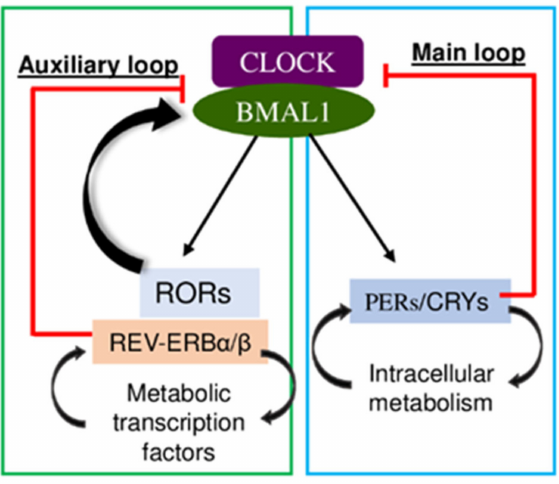
Figure 3. Clock and Bmal1 drive expression of two negative-feedback arms controlled by Pe- riod/Cryptochrome ( Per / Cry ) and the two paralogs, Rev-Erb α / β and ROR . In turn, these negative- feedback arms repress Bmal1/Clock transactivation function (Per/Cry) or Bmal1 expression (Rev- Erb α / β ) and Bmal1 activation (ROR).